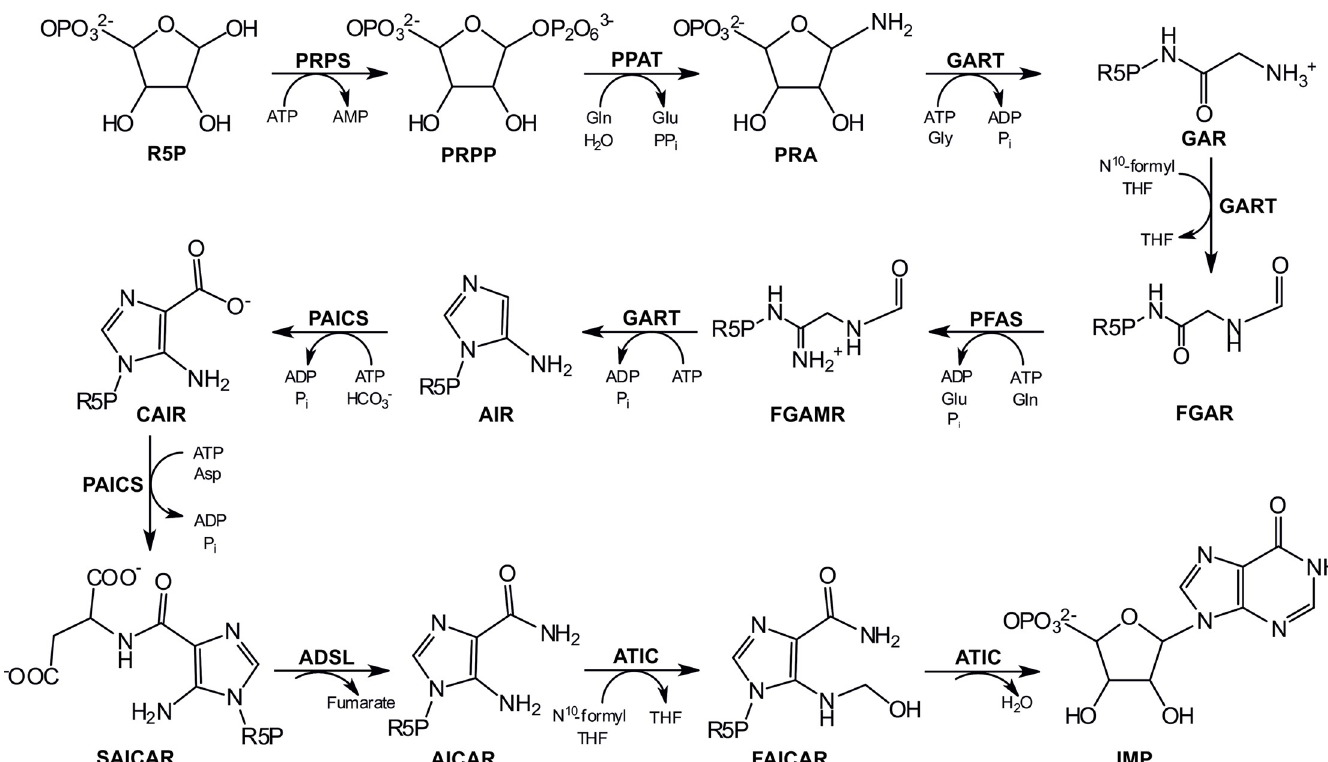
Fig 1. Purine de novo synthesis in humans. Abbreviations: phosphoribosylamine (PRA), glycinamideribonucleotide (GAR), N-formylglycinamide ribonucleotide (FGAR), N-formylglycinamidine ribonucleotide (FGAMR), aminoimidazole ribonucleotide (AIR), carboxyaminoimidazole ribonucleotide (CAIR), N- succinocarboxamide-5-aminoimidazole ribonucleotide (SAICAR), 5-aminoimidazole-4-carboxamide ribonucleotide (AICAR), 5-formamido-4-imidazolecarboxamide ribonucleotide (FAICAR), inosine-5-monophosphate (IMP), glutamine (Gln), glutamate (Glu), pyrophosphate (PPi), adenosine-5’-triphosphate (ATP), adenosine 5’- diphosphate (ADP), glycine (Gly), phosphate (Pi), N 10 -formyl tetrahydrofolate (N 10 -formyl THF), tetrahydrofolate (THF), hydrogen carbonic acid (HCO 3- ), aspartate (Asp). For enzyme abbreviations, see the second paragraph of the Introduction.